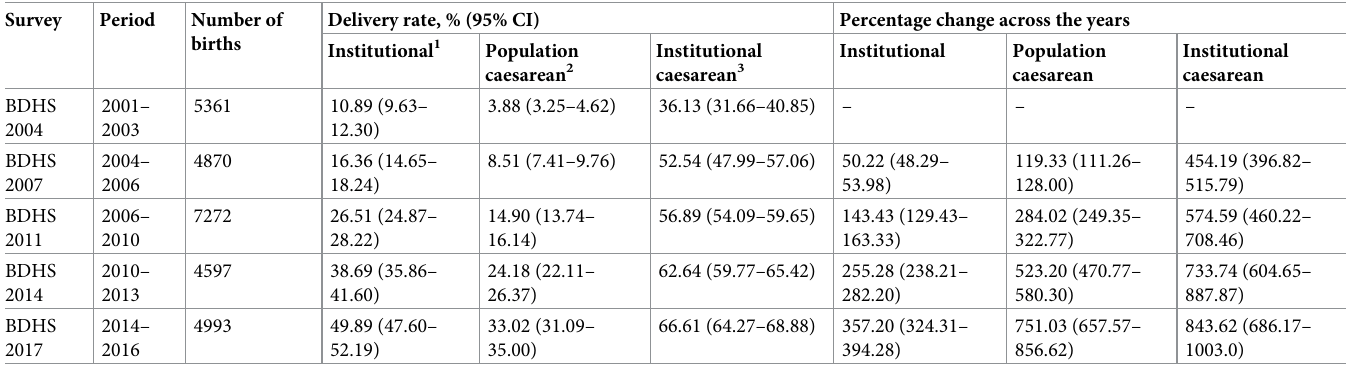
Table 2. Institutional delivery and caesarean delivery rates and changes in Bangladesh, 2004 to 2017/18.